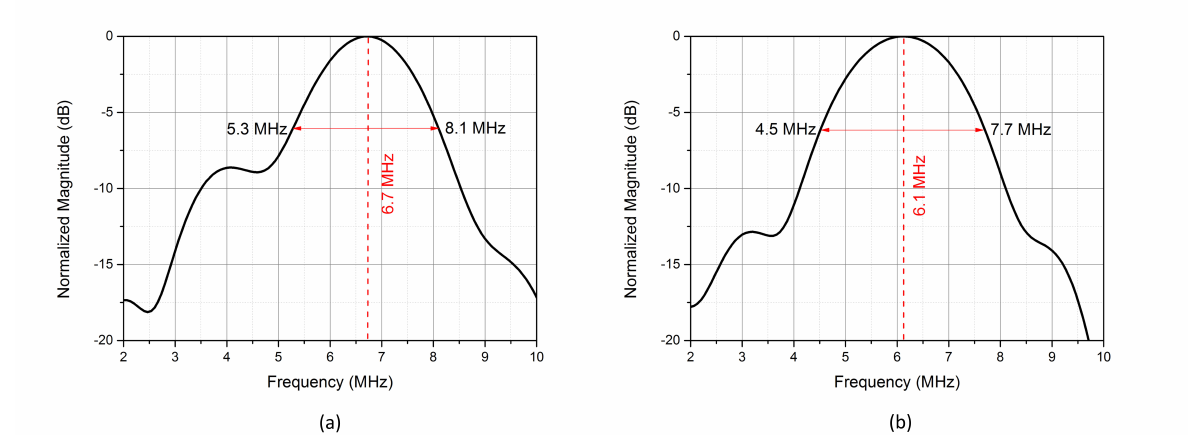
Figure 10. Normalized frequency spectrum of output pressures generated by ( a ) the uniform CMUT cell and ( b ) the embossed CMUT cell biased at 170